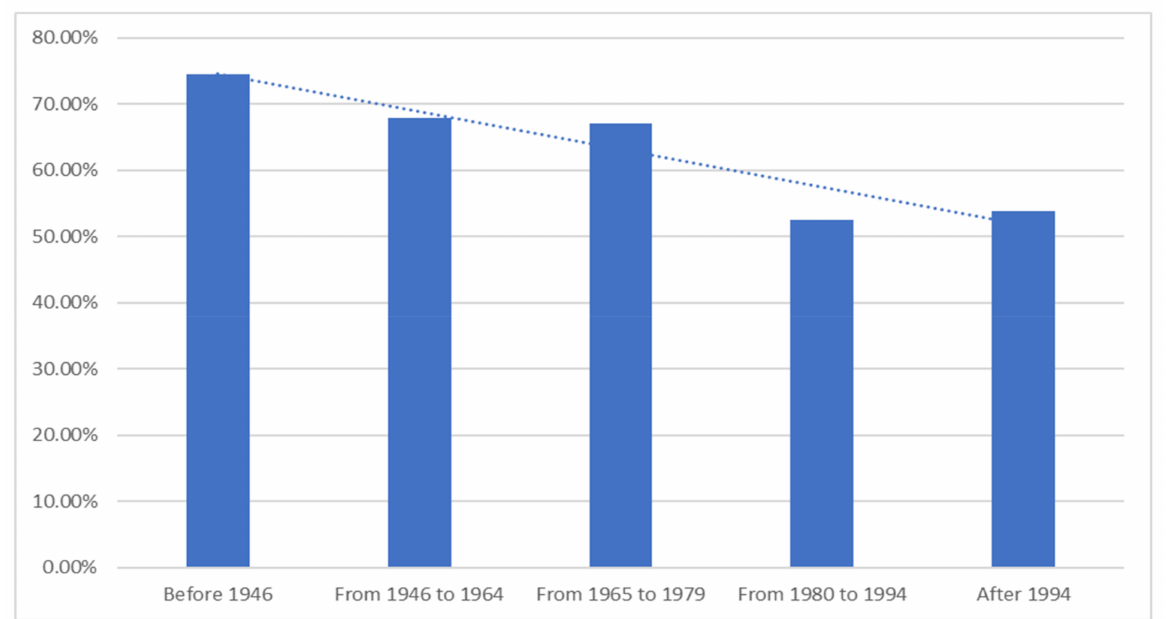
Figure 7. I believe it is important to support Canadian dairy farms by buying Canadian dairy